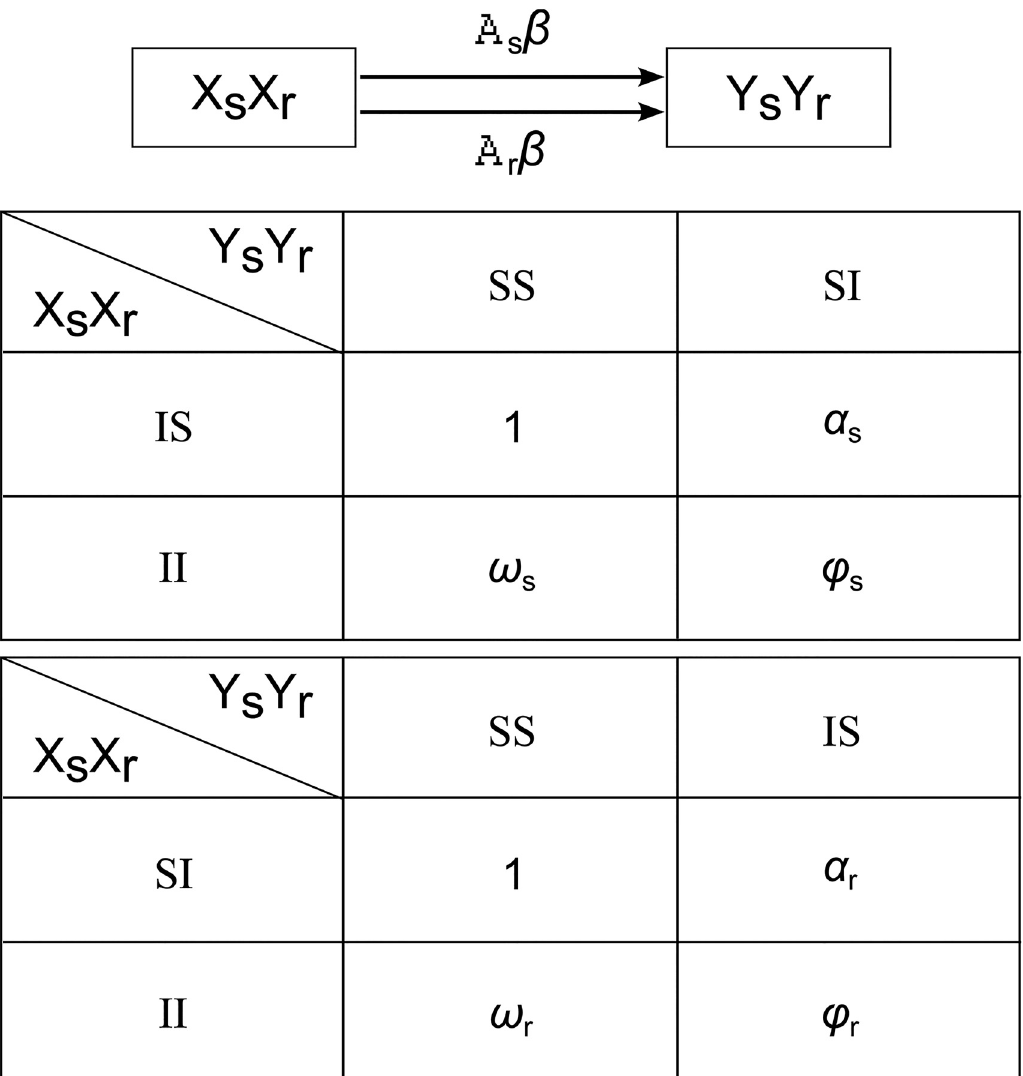
Fig 1. Transmission mechanism for treatment-sensitive and treatment-resistant gonorrhoea as implemented in the model. Xs, Xr denote the infection status of person X: Xs = S if X is susceptible to treatment-sensitive gonorrhoea; Xs = I if X is infected with treatment-sensitive gonorrhoea. Similarly, Xr = S or Xr = I if X is susceptible or infected with treatment-resistant gonorrhoea, respectively. The diagram represents transmission from person X to person Y through unprotected sex act (transmission from Y to X is omitted in this diagram). The parameter β is the transmission probability per unprotected sex act. The parameters A s and A r are scalar adjustment to the transmission probability for treatment-sensitive and treatment-resistant gonorrhoea, respectively, and their value will be based on the infection status of person X and person Y as defined in the figure. A s and A r are equal to zero for all combinations not listed.